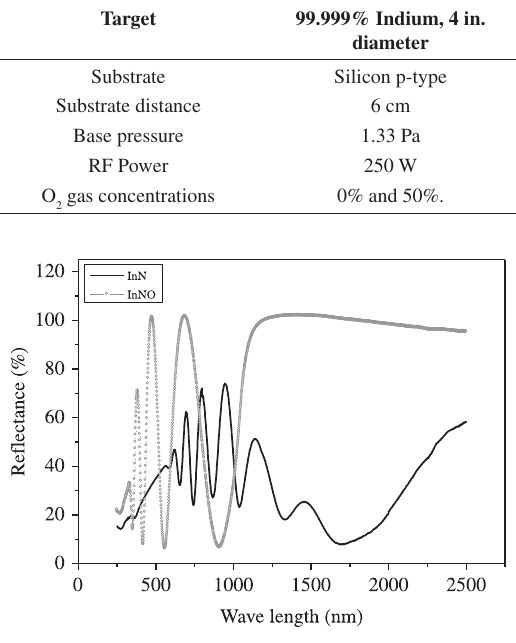
Figure 1. Reflectance spectra for indium nitride and indium oxynitride thin films. Figure 2. Photoluminescence spectra of InNO